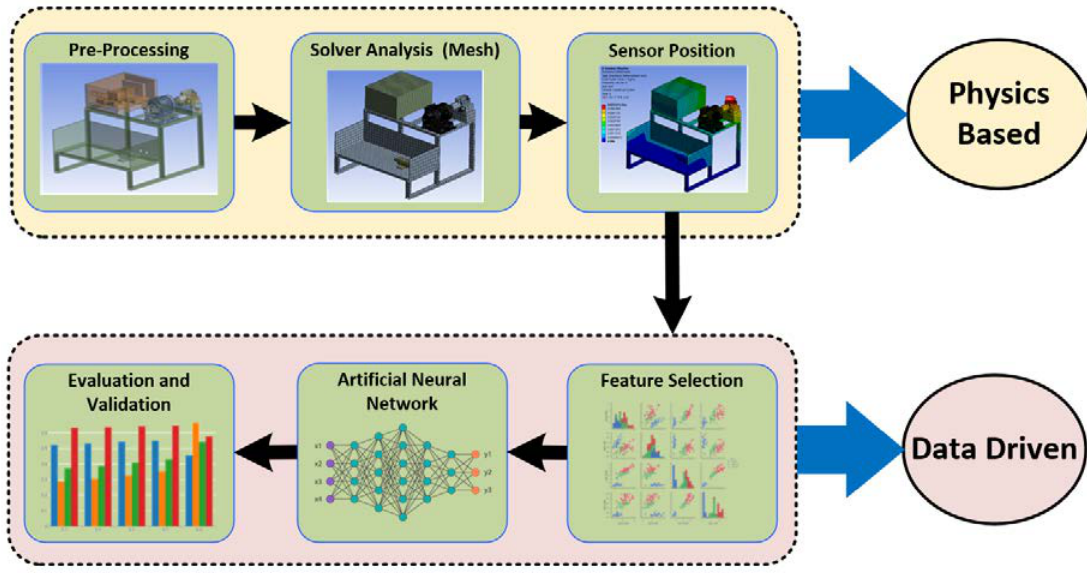
Figure 1. Proposed hybrid FDI method.